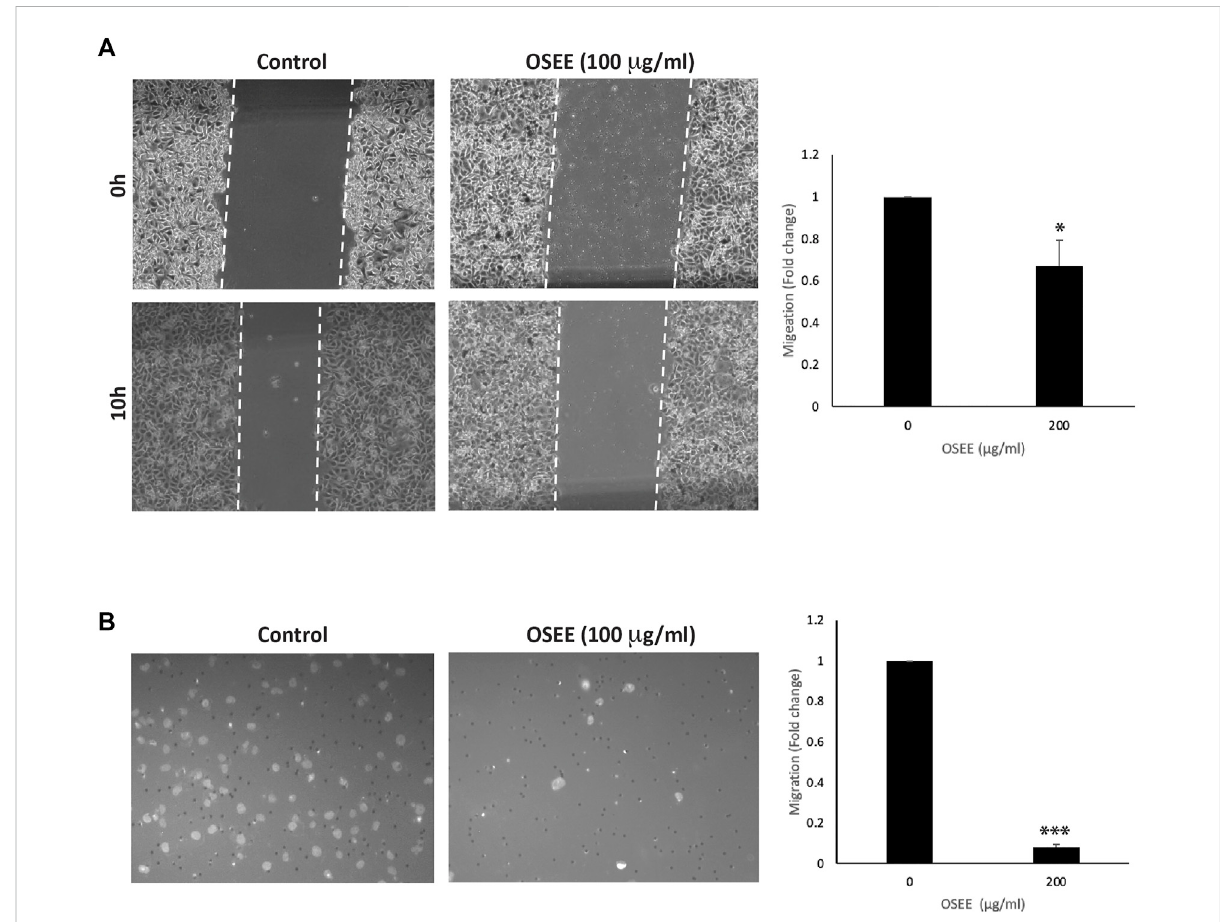
FIGURE 8 O. syriacum inhibits the migration of MDA-MB-231 cells. (A) A con fl uent culture of MDA-MB-231 cells was wounded by scratching with a pipette tip.The cells werethen incubated with and withouttheindicated concentrations of OSEE. After 10 h, thewound wasphotographed usingan inverted phase-contrast microscope and then measured and analyzed. Values represent the fold change in migration compared to vehicle control cells. (B) MDA-MB-231 cells were incubated overnight with and without the indicated concentrations of OSEE in Boyden chamber trans-well inserts as described in Materials and Methods. Migrating cells at the bottom of the chamber were stained with DAPI, imaged, and then counted and analyzed. Values represent the average of three independent experiments and are represented as mean ± SEM (* p < 0.05, *** p <